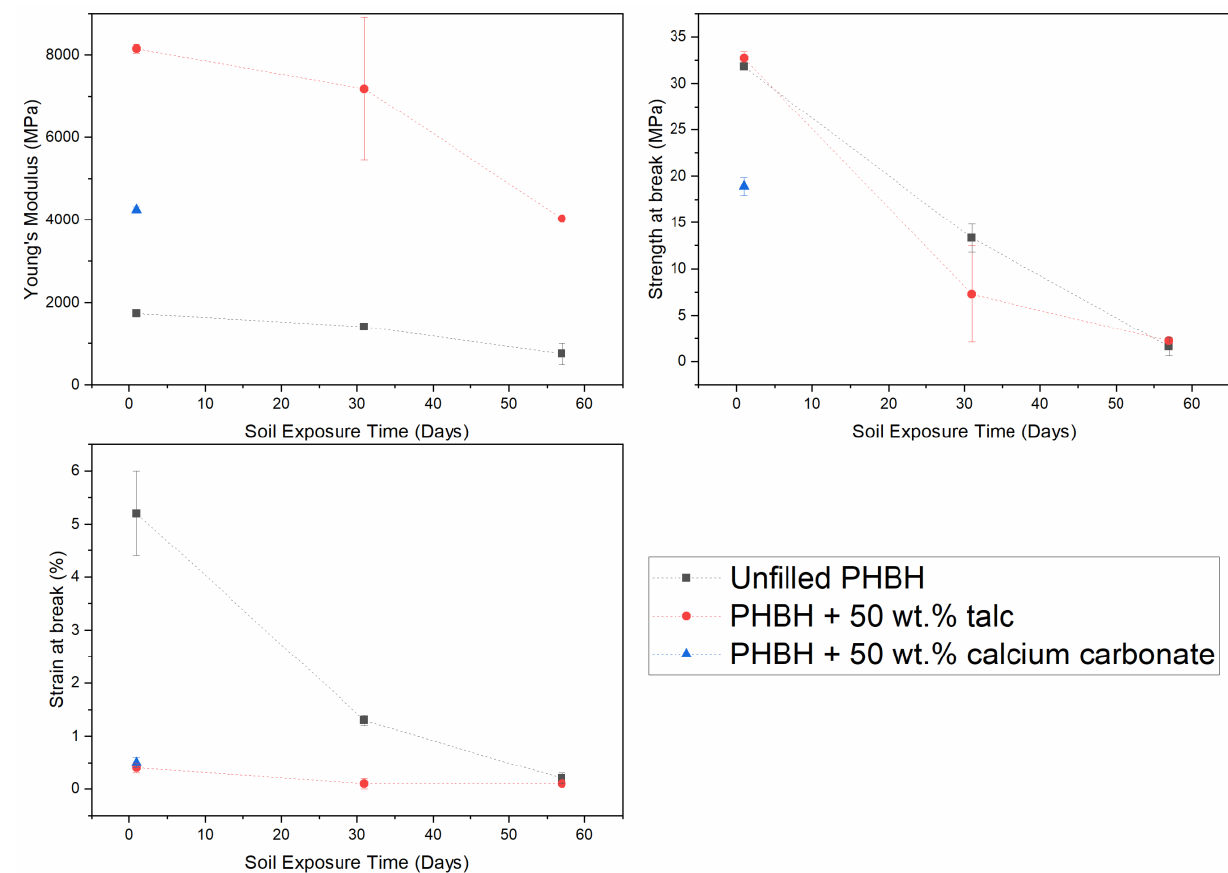
Figure 8. Effect of biodegradation in soil on the mechanical properties of calcium carbonate-/talc-filled PHBH.